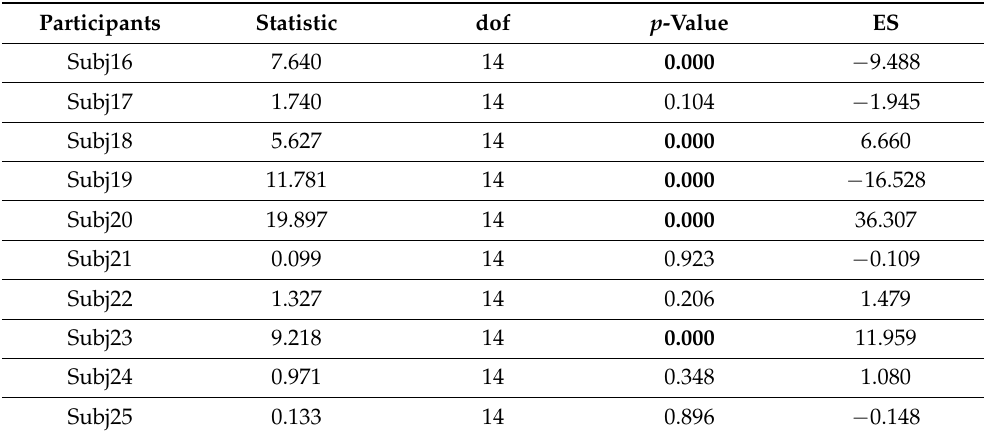
Table 6. Patients’ performance in L-FT.